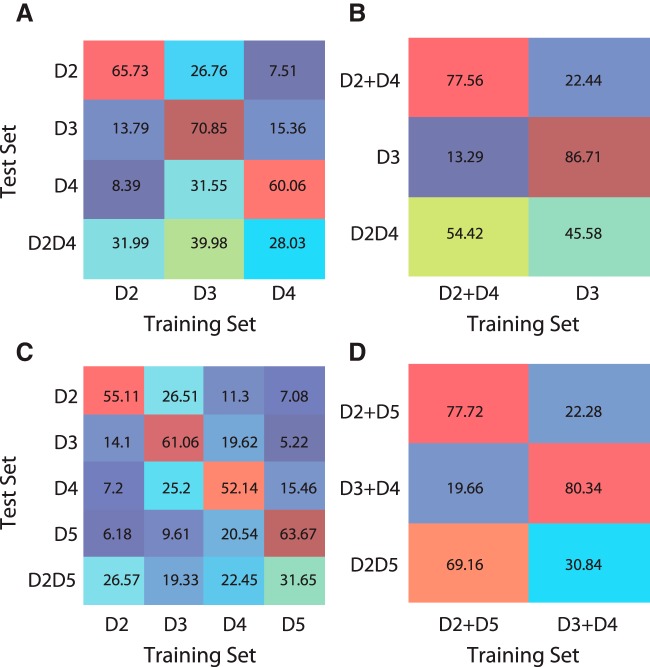
Decoding results. Confusion matrices obtained with a k nearest neighbors classifier (k = 4). A, D2D4 population response classification. The classifier was trained with D2, D3, and D4 trials. Among the whole population, 94 neurons were chosen randomly, and 50 random subsets of 20 trials were used for each selected neuron. For every subset of 20 trials, all 20 different combinations of 19 + 1 were used to train and test the classifier. This procedure was repeated 100 times. The confusion matrices show the distribution of the 100,000 (100 * 50 *20) classifier choices. The most often chosen digit is D3, the center nonstimulated digit (39.98% > 33.33%, chance level). B, Confusion matrix for a classifier trained with D3 and D2 + D4 trials. Neurons with their maximal response probability for D2 and D4 stimulation were grouped, as for trials where these digits were stimulated alone. This merging creates an artificial condition in which responses of D2 population for D2, and responses of D4 population for D4, are added. This condition allows us to verify whether the classifier would chose D3 over the simple addition of D2 and D4 responses. Decoding results indicate that addition of D2 + D4 was chosen more often. C, D2D5 population response classification. The classifier was trained with D2, D3, D4, and D5 trials. D, Confusion matrix for a classifier trained with D2 + D5 and D3 + D4, which indicated an advantage for the addition of edge digits’ responses.